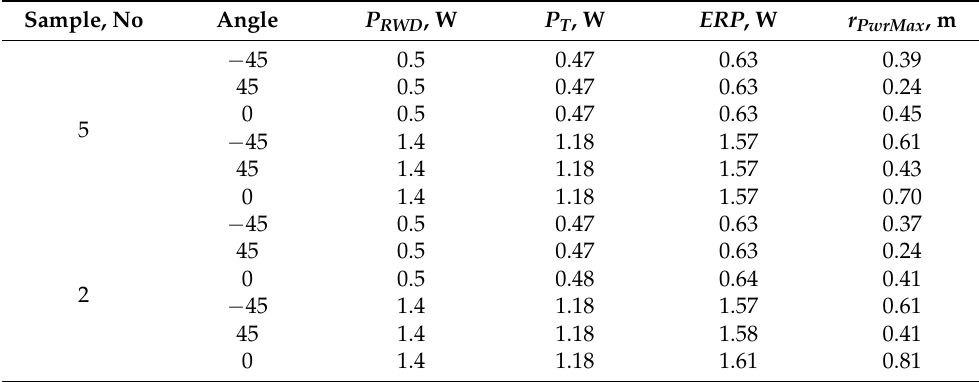
Table 1. Read range r PwRMax of test samples 5 and 6 for RFID sensor deflection, V BAT = 0. Sample,